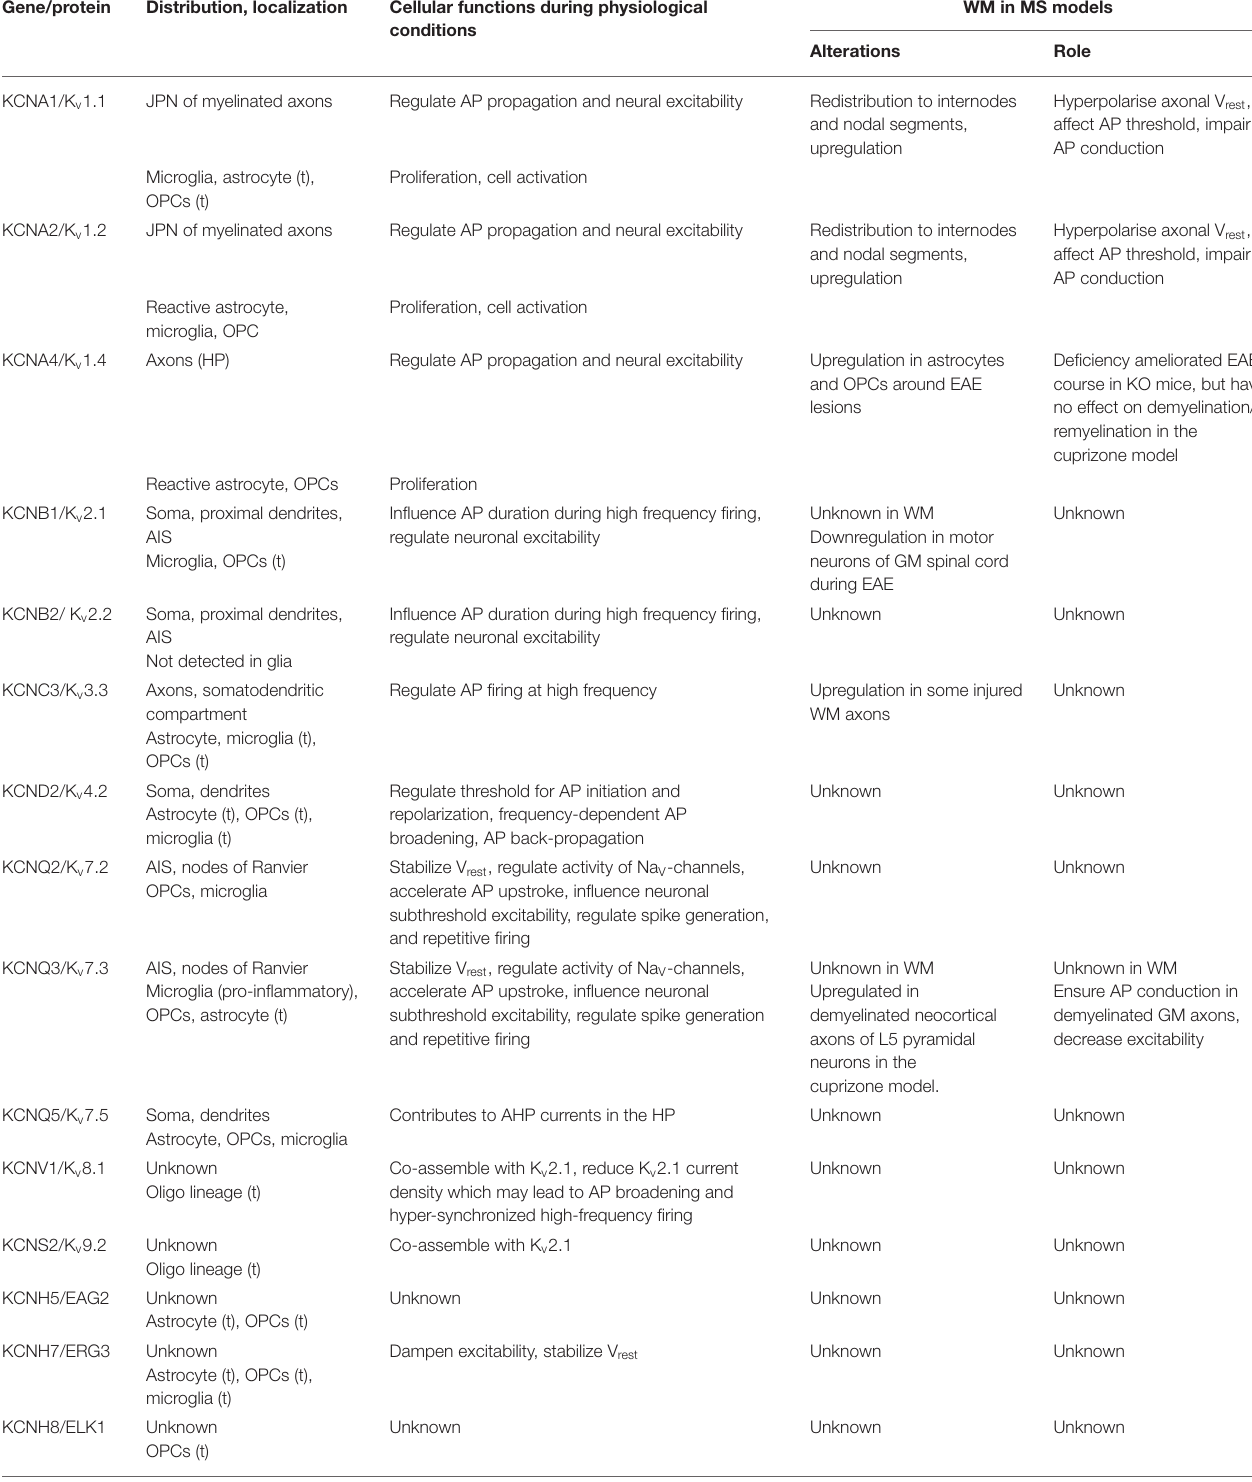
TABLE 3 | Expression and role of unique dysregulated ion channels in experimental models of MS.